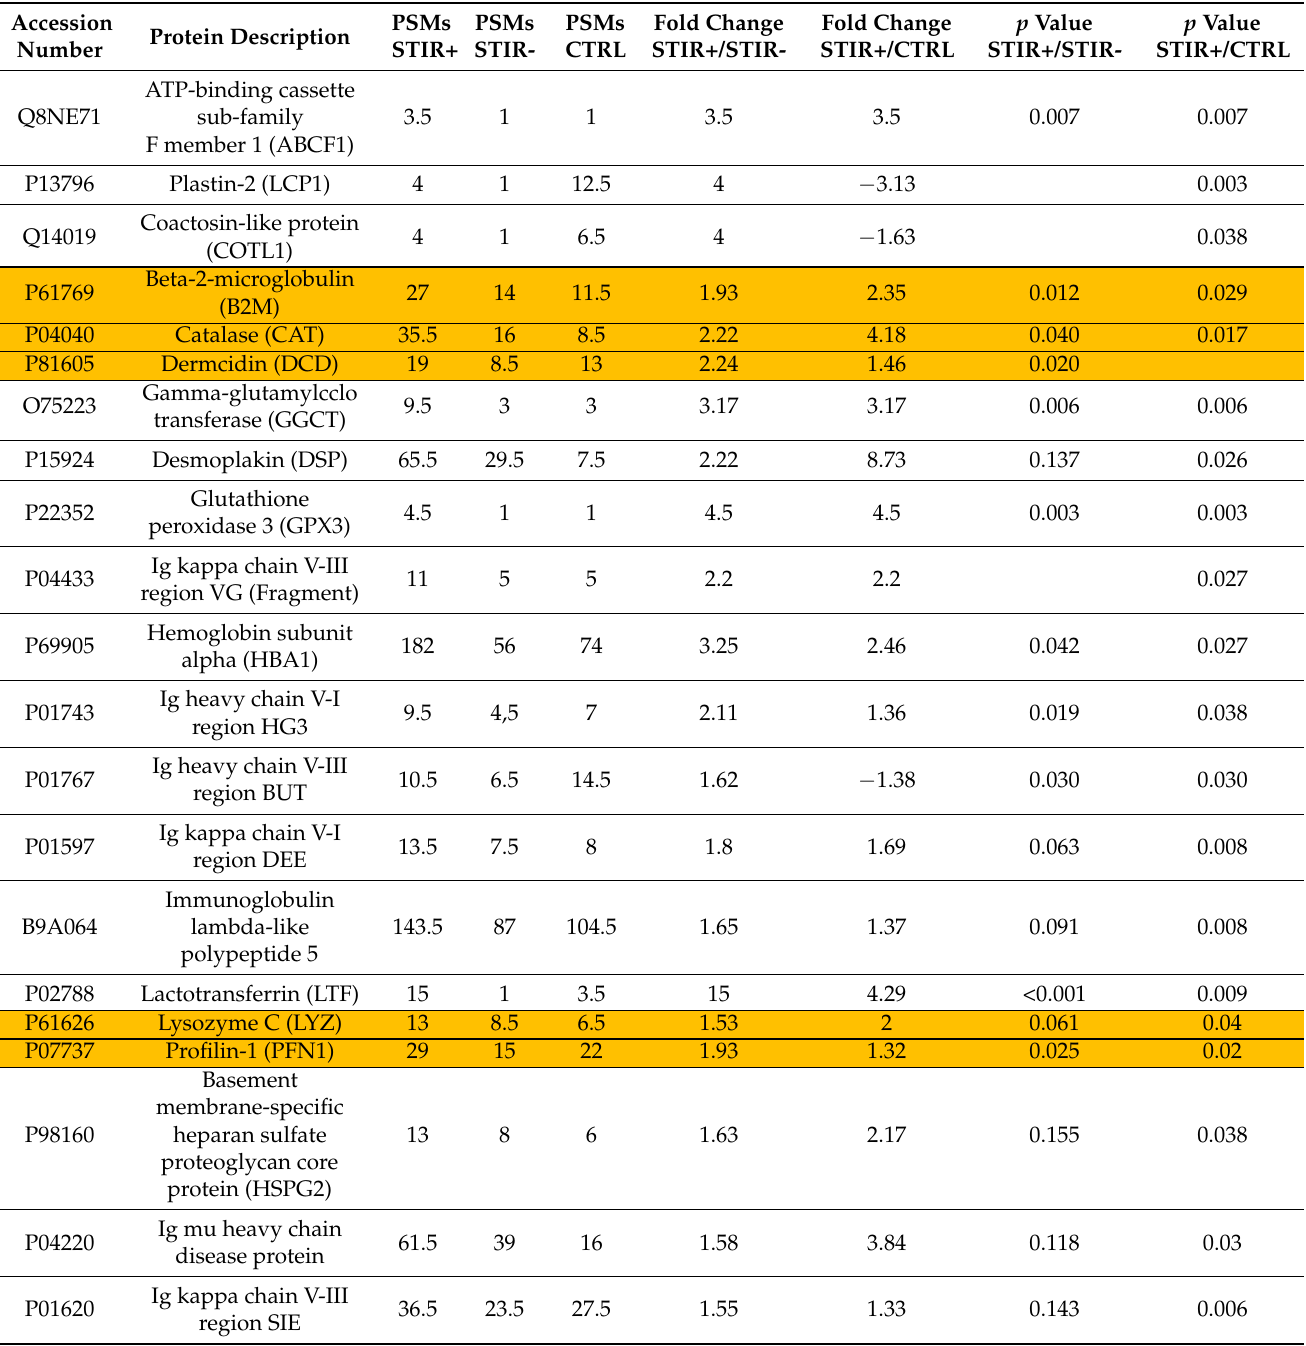
Table 3. Label free analysis of proteins identified by